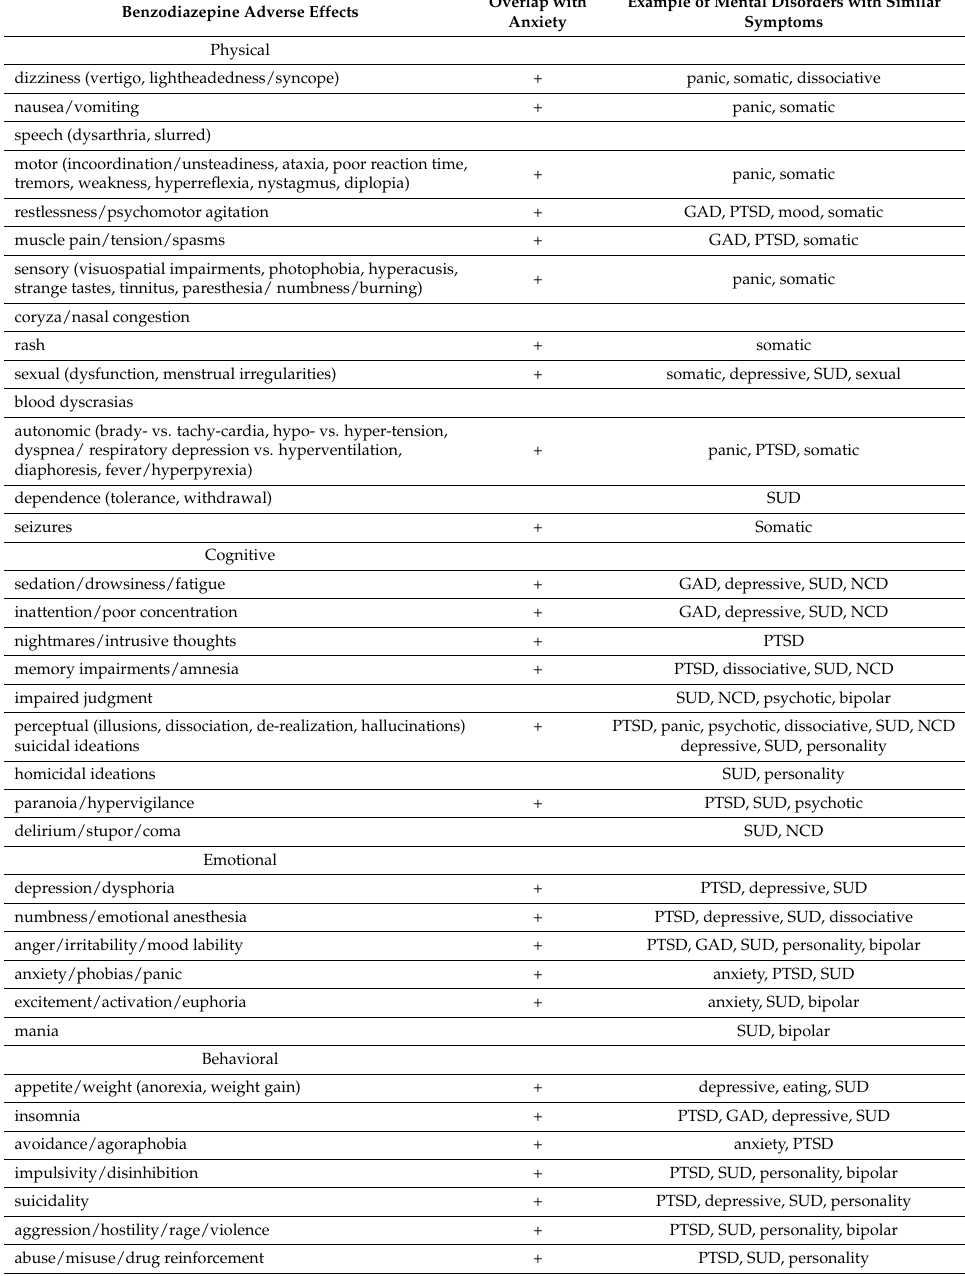
Table 2. Benzodiazepine adverse effects that overlap with core symptoms, associated symptoms and common comorbidities of